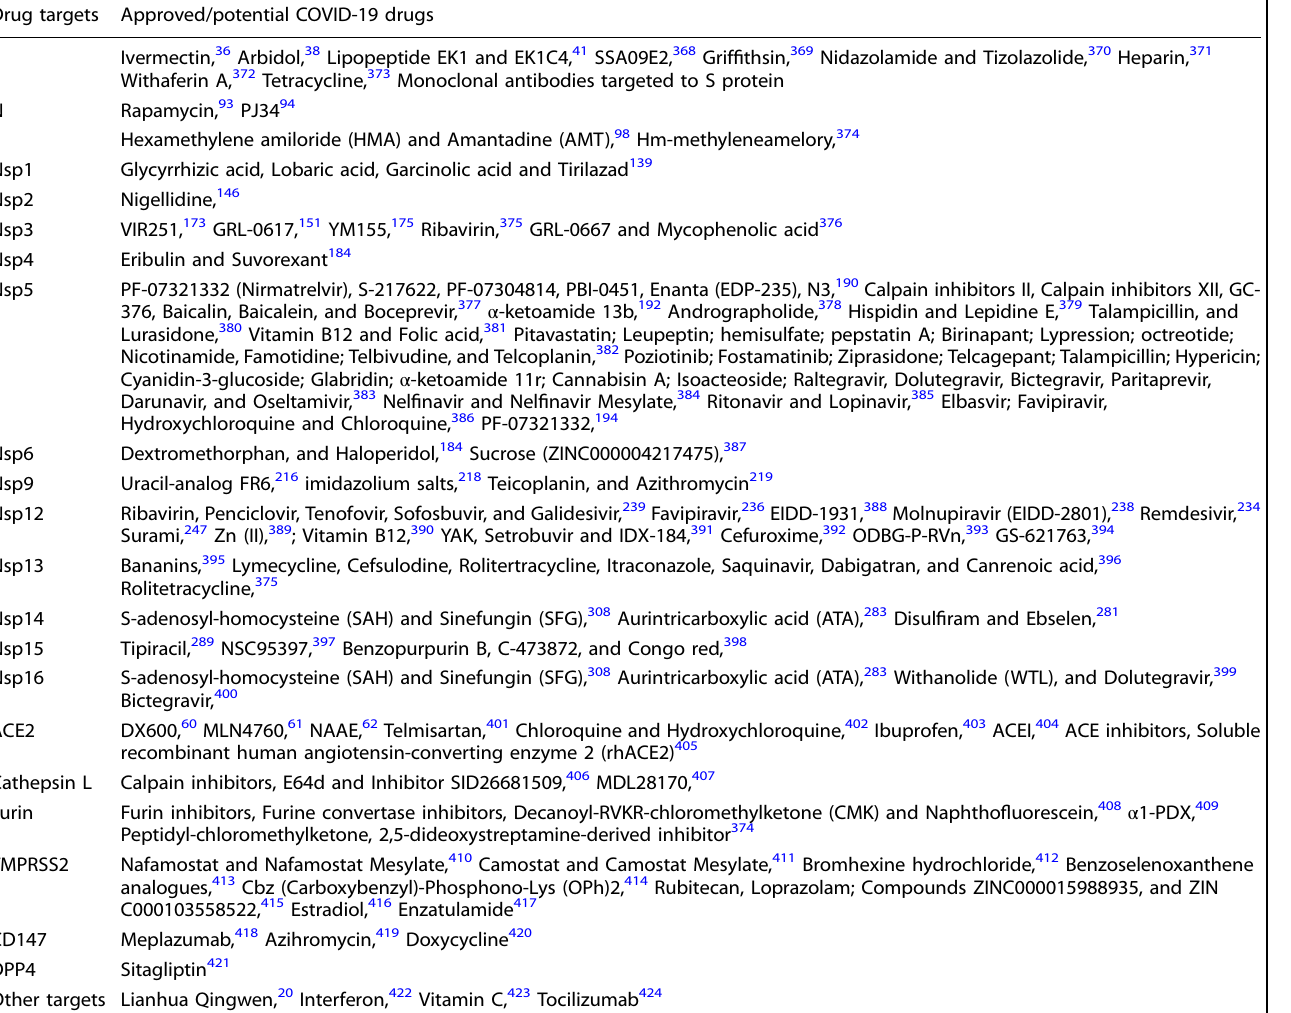
Table 2. Overview of targets and potential drugs of SARS-CoV-2 Drug targets Approved/potential COVID-19